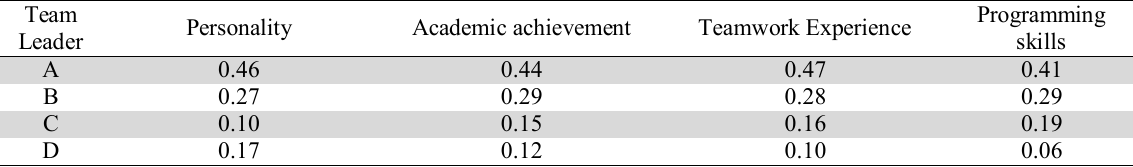
Performance Ratings of Team